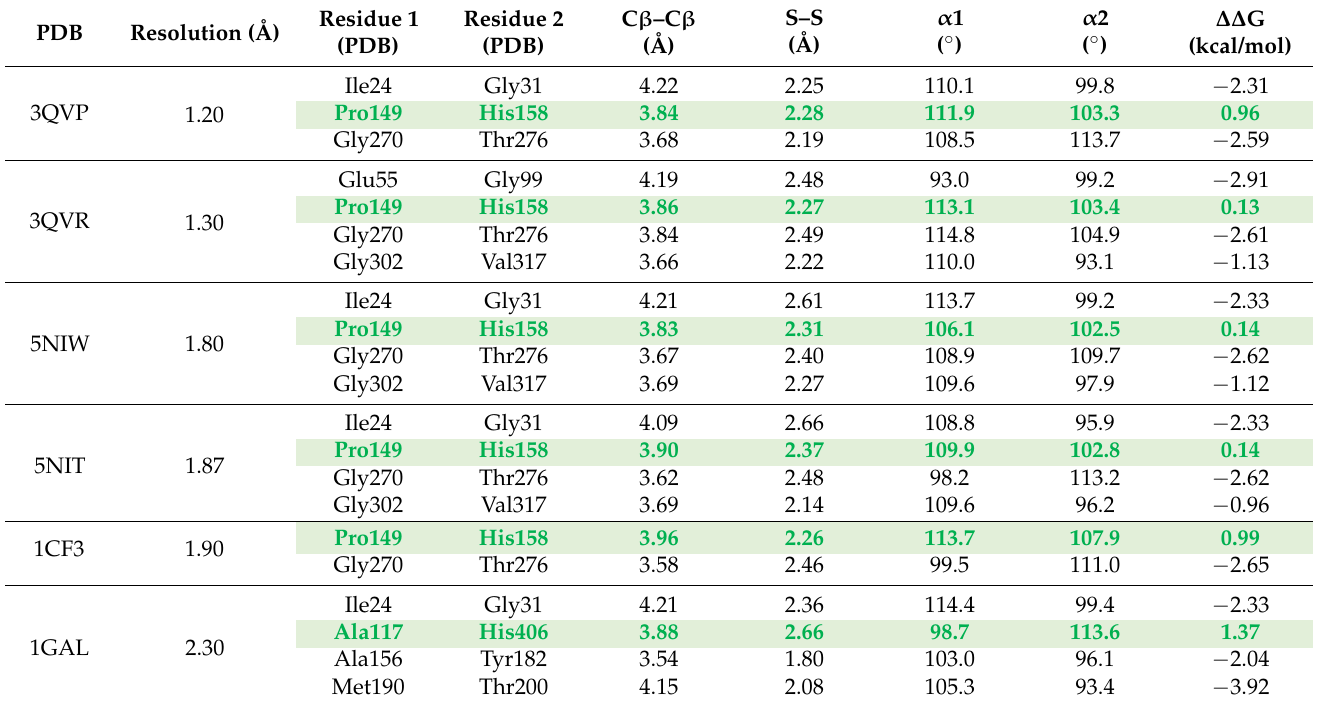
Figure 2. Three-dimensional (3D) structures of GOx (C α trace and surface of the PDB structure 3QVP). Eight possible pairs for cysteine mutations are mapped onto this structure and are represented by spheres with sulfur atoms shown in yellow. Numbers shown in this figure indicate residue numbers according to the PDB coordinates. FAD (shown in red) can be found located at the pocket of the active site inside the protein. More details from different angles are shown in Supplementary Figure S1 (in Supplementary File S3) and Supplementary Video S1. Table 1. Candidate residue pairs for cysteine mutations. Residue numbers are based on PDB coordinates. Mutation pairs that were predicted stabilizing (positive ∆∆ G) are highlighted in